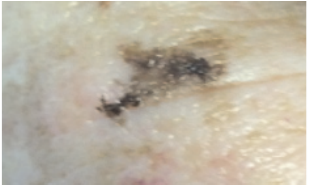
Figure 2: Presentation of lesion after 1,064 nm QS Nd:YAG laser therapy: 4 mm x 2 mm asymmetric macule colored tan to dark brown to black involving the lateral segment of the right inferior